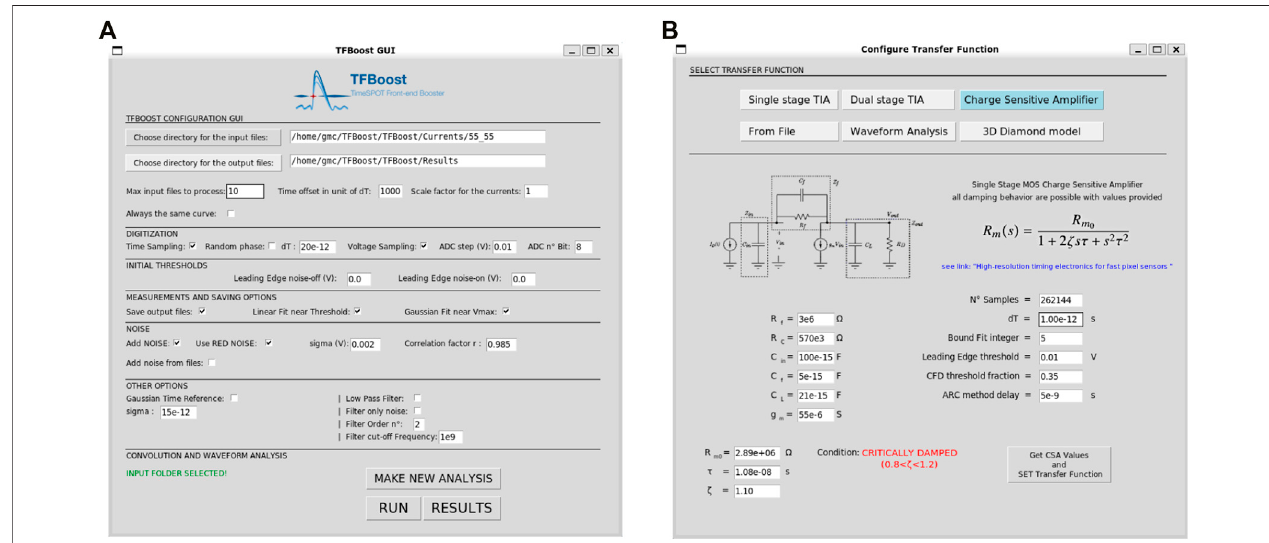
FIGURE 7 | TFBoost Graphical User Interface: (A) main window of the GUI where all steps and functionalities can be set; (B) the transfer function con fi guration window, from which it is possible to make just a waveform analysis, or to choose the transfer functions among the analytical models or from a fi le.